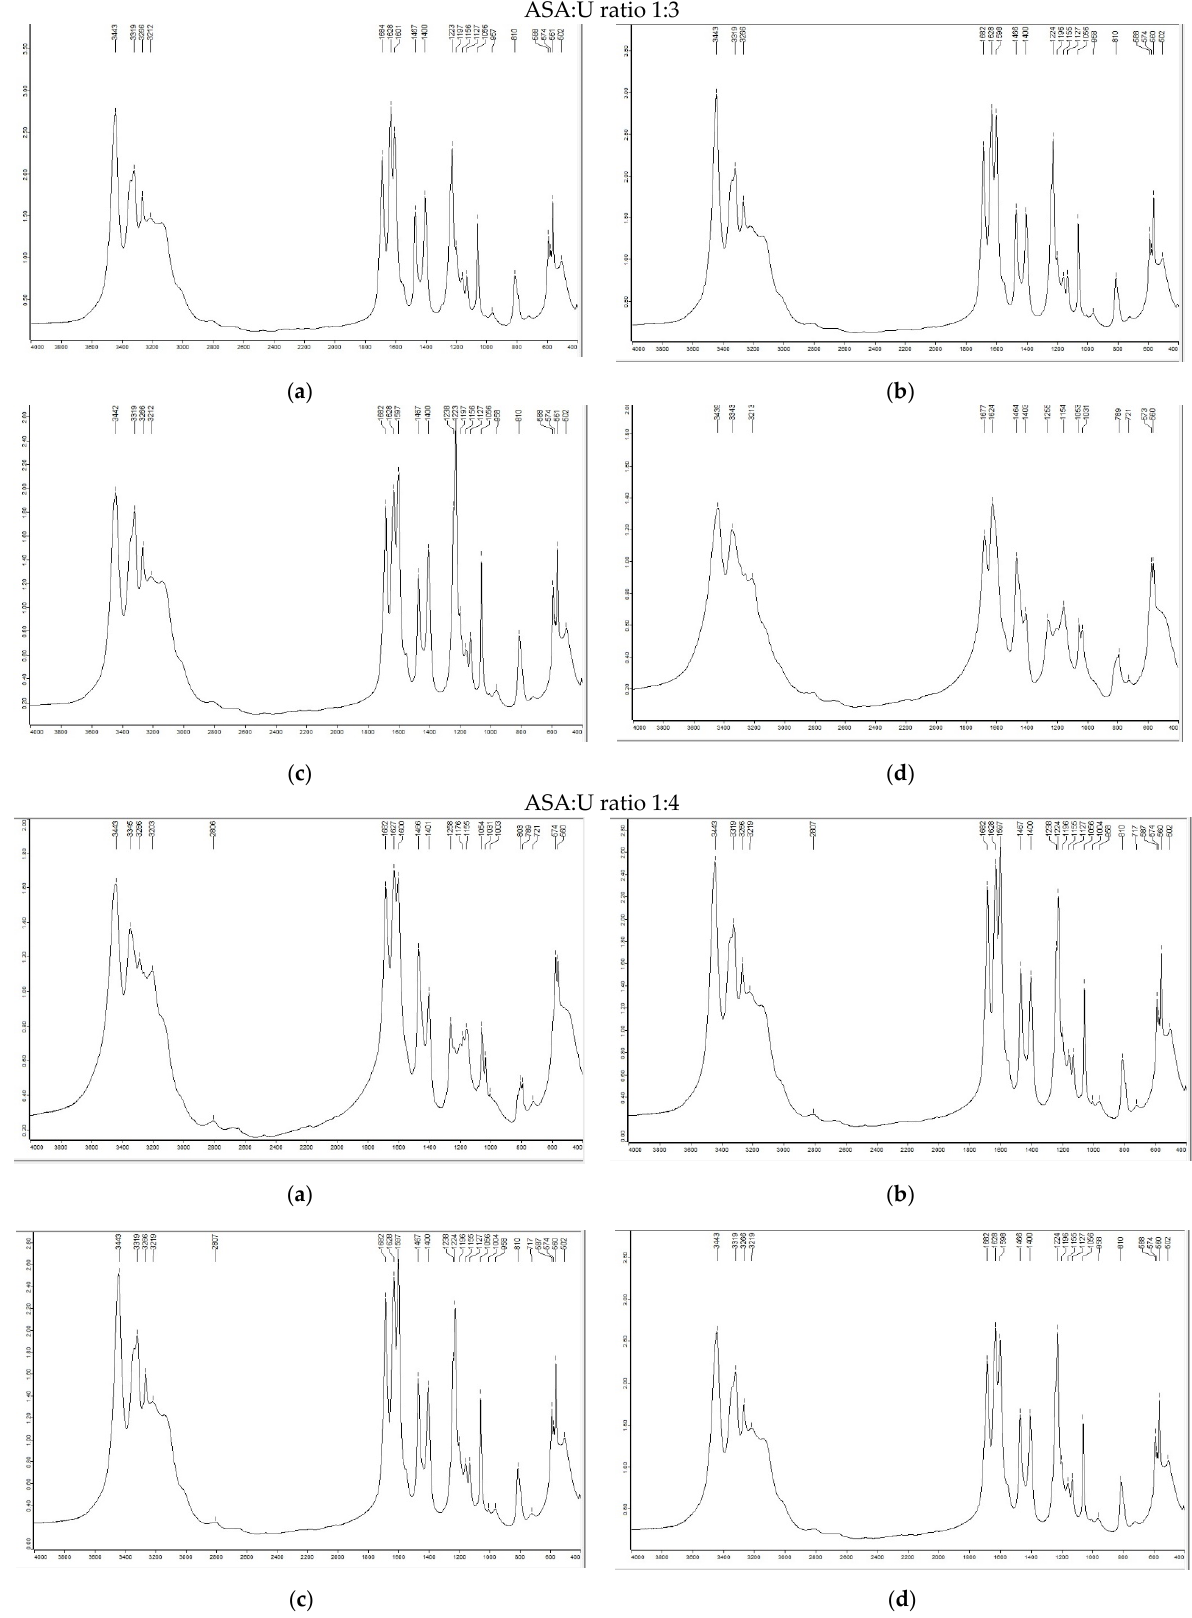
Figure 1. FTIR spectra of the ammonium sulfamate–urea system with different component ratios after heating at 100 °C for ( a ) 0, ( b ) 5, ( c ) 15, and ( d ) 30 min. To establish the thermal and chemical stability of the ammonium sulfamate–urea system, samples with different component ratios were examined using FTIR spectrosco- py after heating at 100 °C for 0–30 min (Figure 1). The data obtained (Figure 1) suggest that the chemical interaction between ammonium sulfamate and urea with the formation of new chemical bonds does not occur. In other words, this mixture is chemically and thermally stable at temperatures of up to 100 °C for up to 30 min. For more detail con- cerning the thermochemical properties, see Section 2.1.3 (TGA/DSC). 2.1.2. XRD The XRD analysis is used to identify crystalline phases and determine their relative concentrations in mixtures, unit cell parameters of a known substance for detecting iso- morphic impurities, parameters and possible space groups of new compounds, etc. [26,27]. We carried out the XRD investigations of the ammonium sulfamate–urea samples with different component ratios processed at a temperature of 100 ° С for different times (Figure 2). It can be seen in Figure 2 that a change in the component ratio in the ammonium sulfamate–urea system is reflected in a change in the XRD spectra. In particular, the peaks at 35 and 45° 2 Ɵ increase significantly with the urea content in the system. Heating of the investigated system changes the XRD spectra. In general, in the re- gion of 24–34° 2 Ɵ , the intensity of the peaks lowers and they slightly shift. However, this is only observed at certain component ratios. At an ammonium sulfamate: urea ratio of 1:1 and a heating time of 5 min, the material is amorphized; as the processing time in- creases, its crystallinity returns.